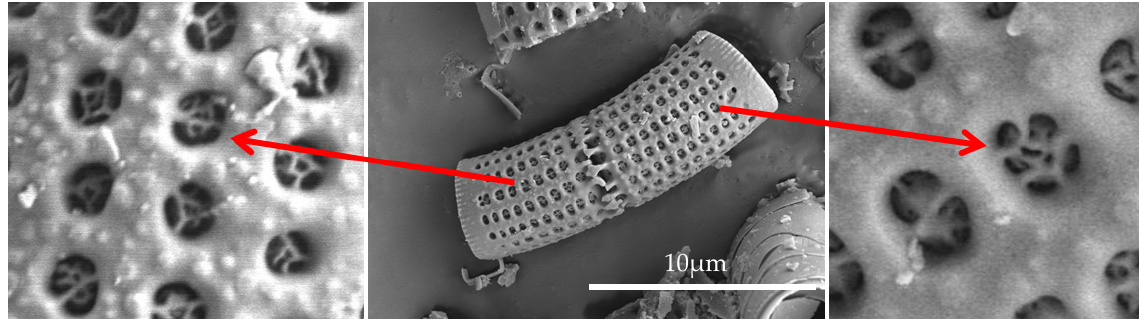
Figure 4. Pores present in the frustule wall.